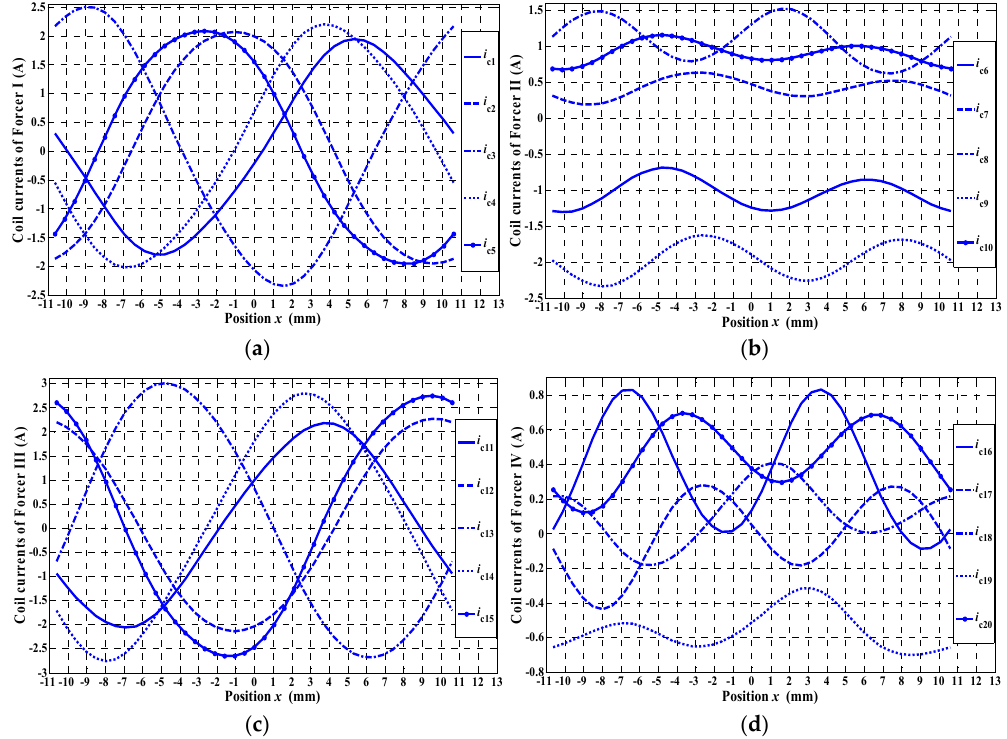
Figure 4. Coil currents of ( a ) Forcer I, ( b ) Forcer II, ( c ) Forcer III, and ( d ) Forcer IV by optimization commutation without boundary constraint I m.